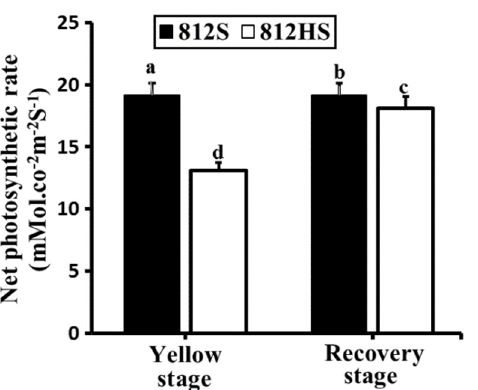
6 of 13 Figure 2. Effect of photooxidation on ( A ) Chl a ( B ) Chl b ( C ) carotenoid content in the rice mutant 812HS. Different letters indicate significant variation ( p < 0.05). 3.3. Net Photosynthetic Rate Photosynthesis provides energy to plants that are needed for their growth. In this